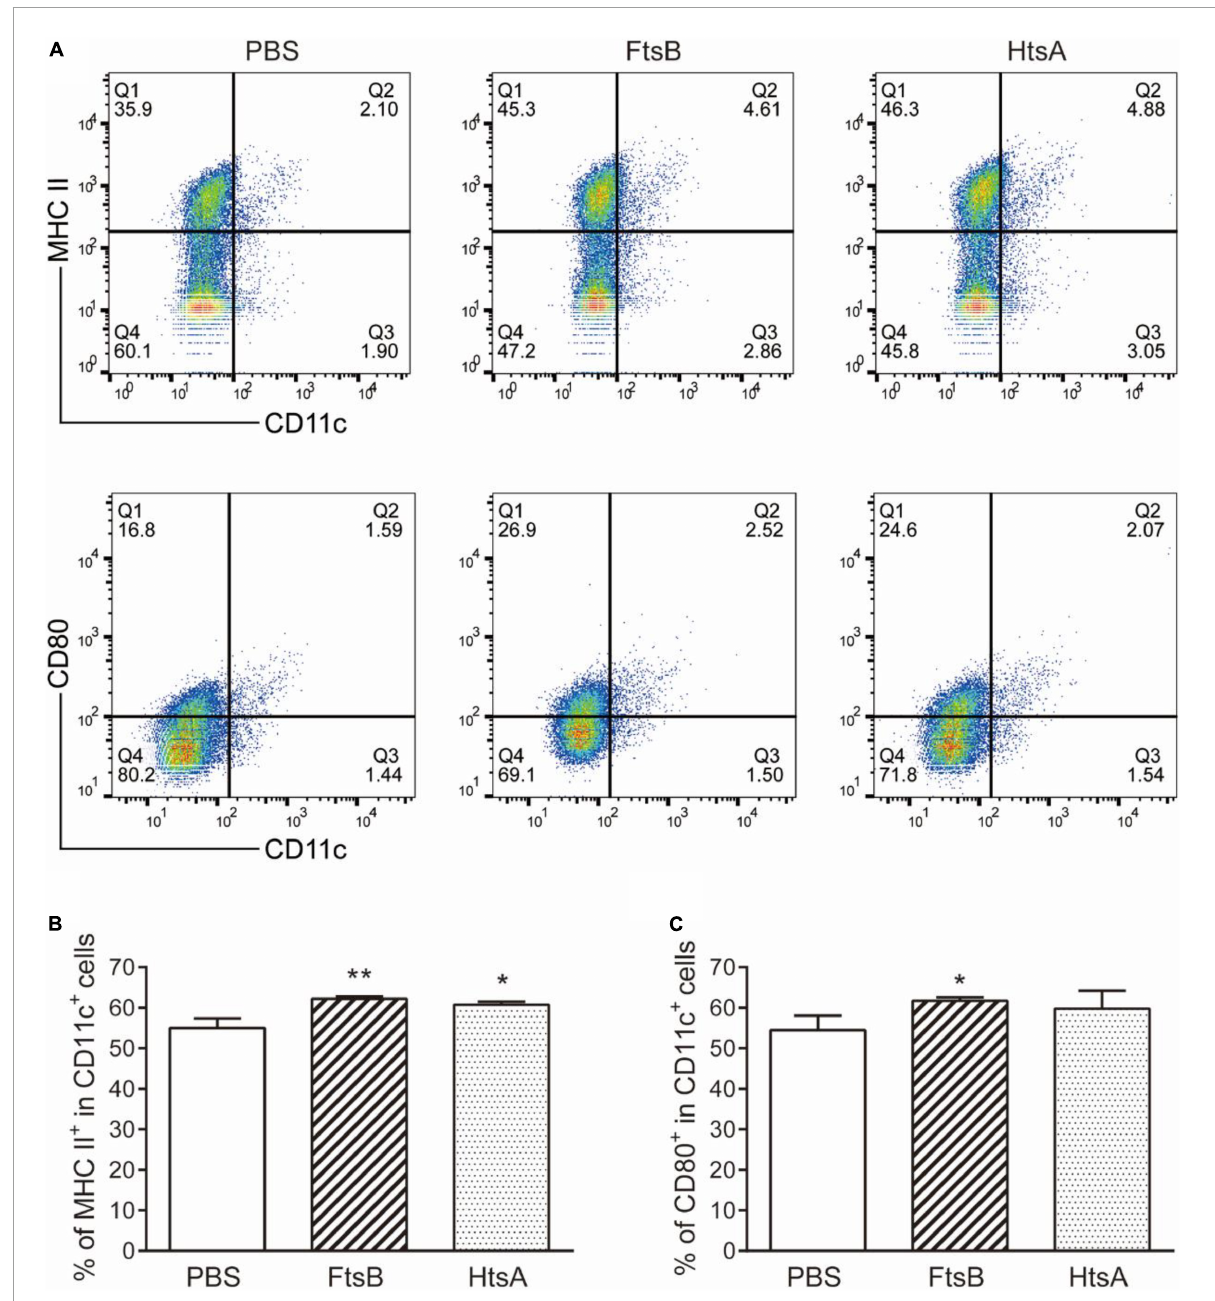
FIGURE8 Immunization with FtsB stimulated the maturation of DCs. (A) Representative flow cytometry graph. (B) The percentage of the costimulatory molecule MHCII expressed on CD11c + DC cells. (C) The percentage of the costimulatory molecule CD80 expressed on CD11c + DCs. n = 5 mice per group, * p < 0.05, ** p < 0.01 vs. PBS control